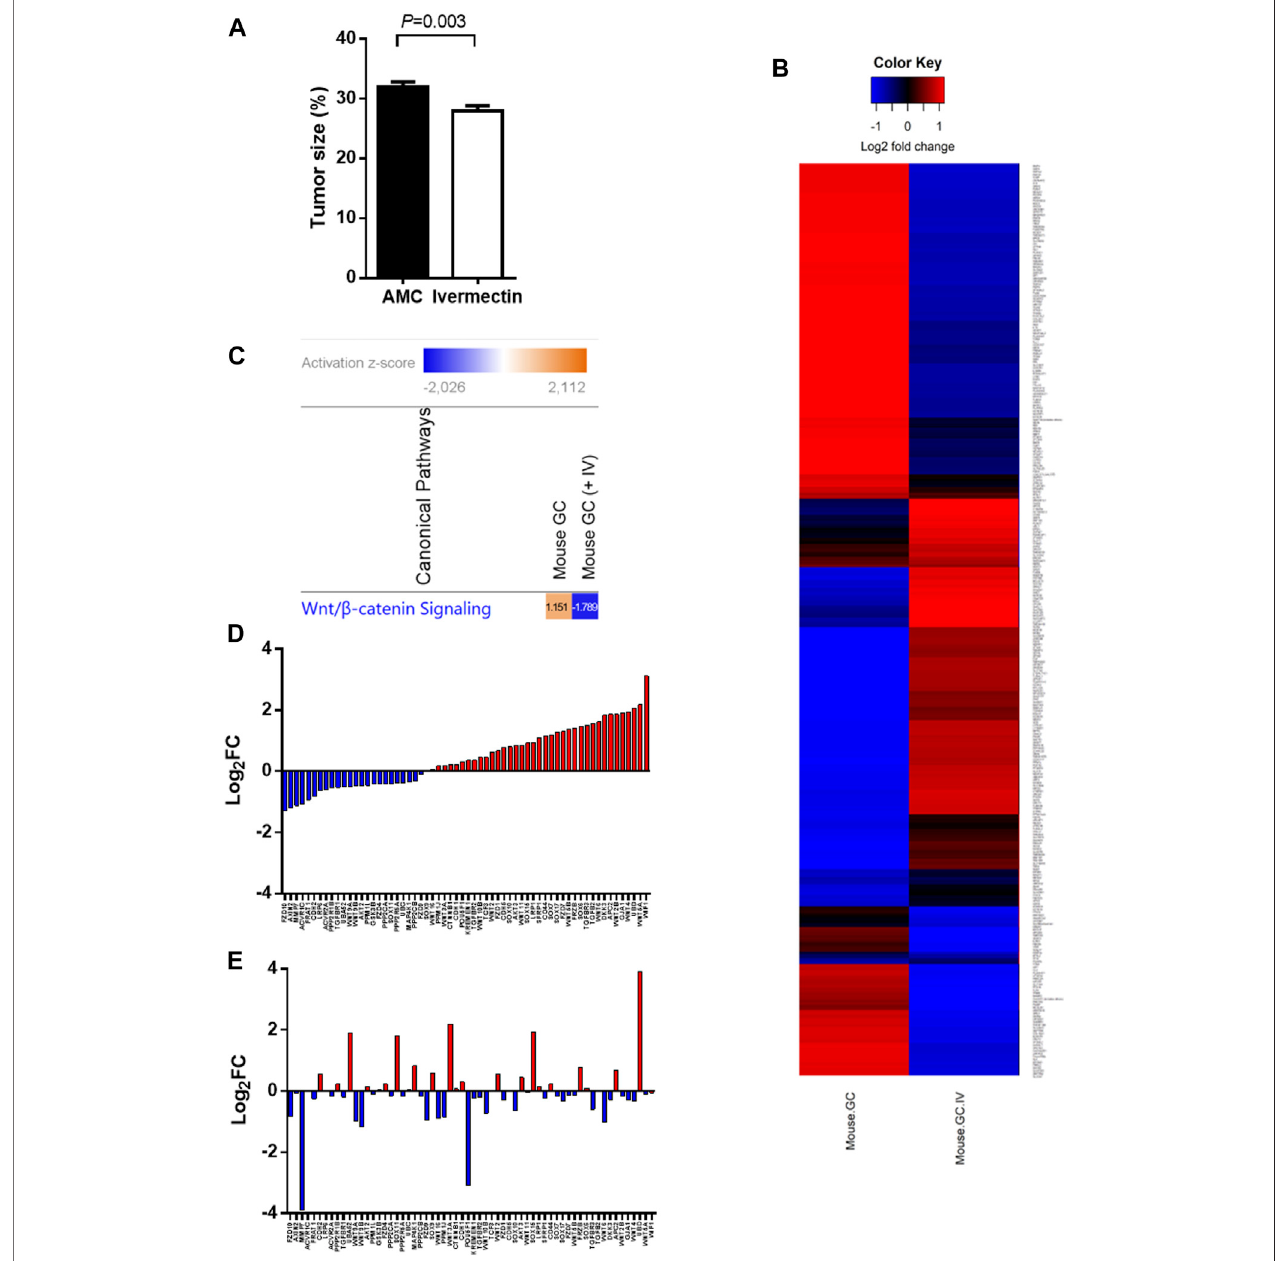
FIGURE6| Tumorsizeandgeneexpressionpro fi lesinresponsetoivermectin. (A) Tumorsize(%ofglandularareaofstomachoccupiedbytumor)inage-matched controls (AMC, n (cid:1) 14) and ivermectin-treated mice ( n (cid:1) 17) (Ivermectin). Independent t-test (2-sided) between group means (normality assumption met). Error bars represent SEM. (B) Global gene expression pro fi le of mouse GC with and without ivermectin treatment (created in RStudio using heatmap.2 function). Only differentially expressed genes with p < 0.05 are included (4,112 genes). (C) WNT/ β -catenin pathway was activated ( z -score (cid:1) 1.151) in mouse GC without treatment but inhibitedinmouseGCwithivermectintreatment( z -score (cid:1)− 1.789). (D,E) WNT/ β -cateningeneexpressionsinmouseGCmicewithouttreatment (D) andwithivermectin treatment (E) . Note: same orders of individual genes in (D) and (E) .